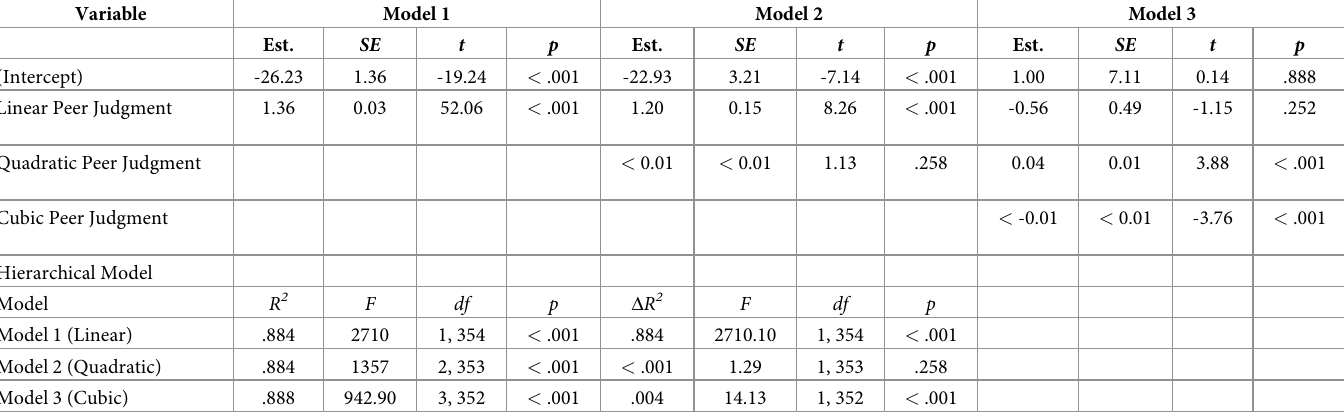
Table 2. Regression estimates and model comparisons of mean peer judgments on the probability of